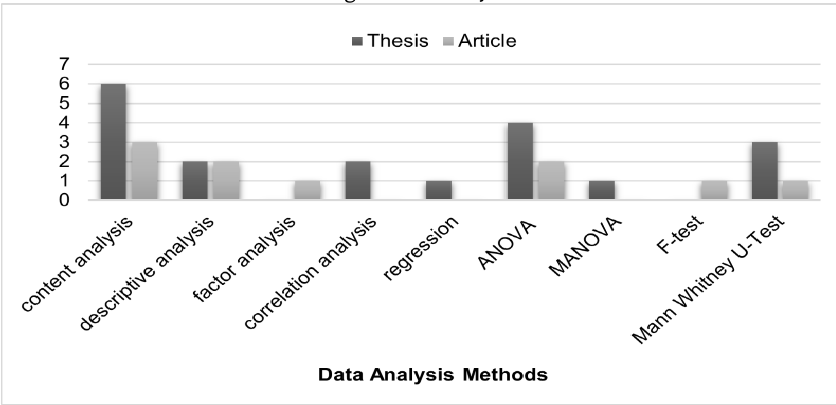
Figure 8: Distribution of Studies According to Data Analysis